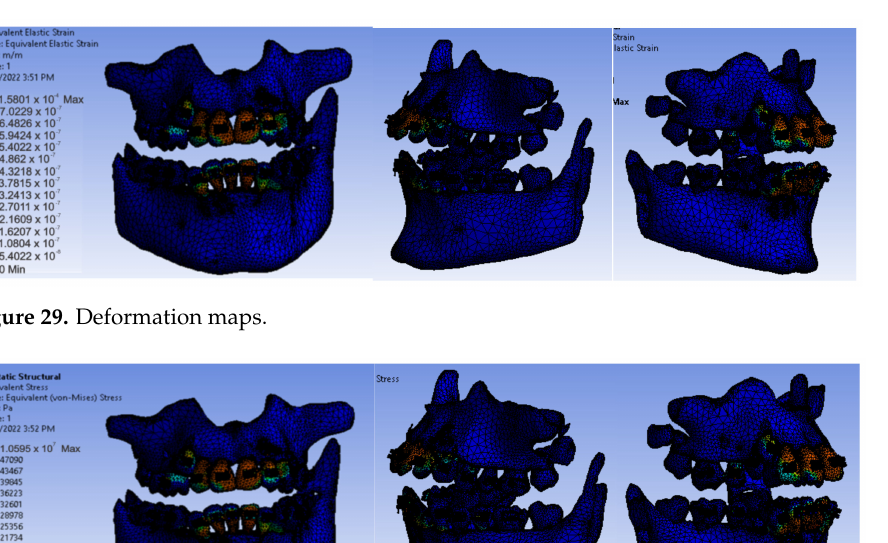
Figure 28. Displacement maps.